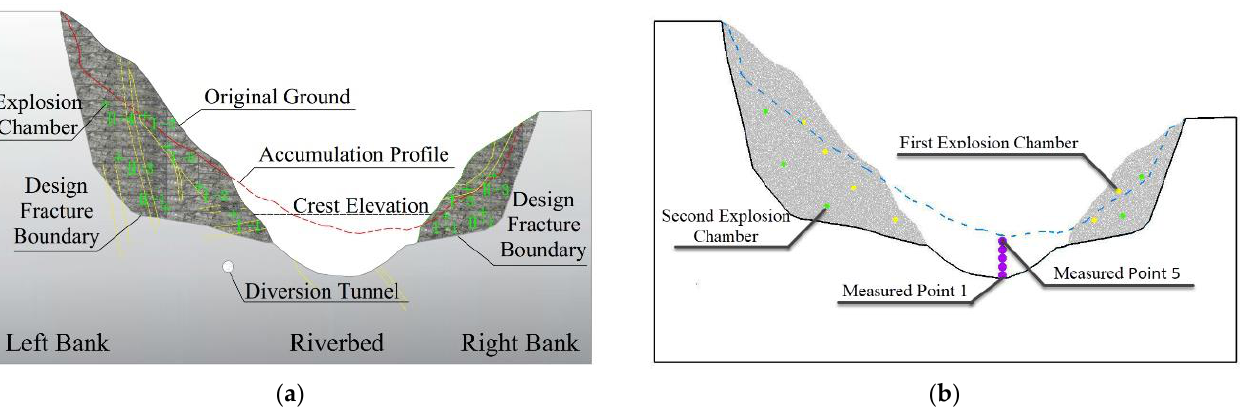
Figure 2. 2D discrete element model of the directional blasting process: ( a ) geological profile at dam axis; ( b ) discrete element model of blasting. Table 3. Microparameters of the blast-fill